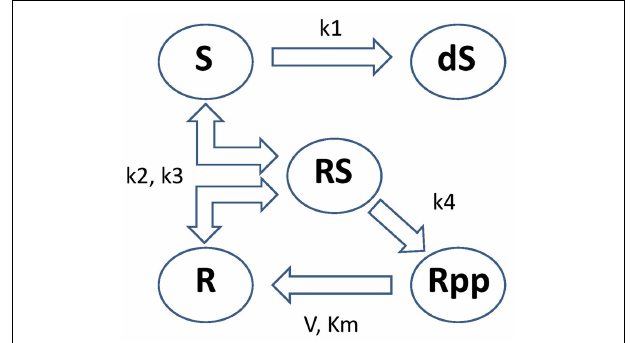
FIGURE 5 | Graphical representation of the protein signaling transduction pathway in equations (63)–(67) . There are 5 “species” ( S, dS, R, RS, Rpp ) and 6 parameters ( k 1 , k 2 , k 3 , k 4 , V , K m ). The system describes the phosphorylation of a protein, R → Rpp [equation (67)], catalyzed by an enzyme S , via an active protein complex [ RS , equation (66)], where the enzyme is subject to degradation [S → dS , equation (64)]. Figure adapted from Vyshemirsky and Girolami (2008).